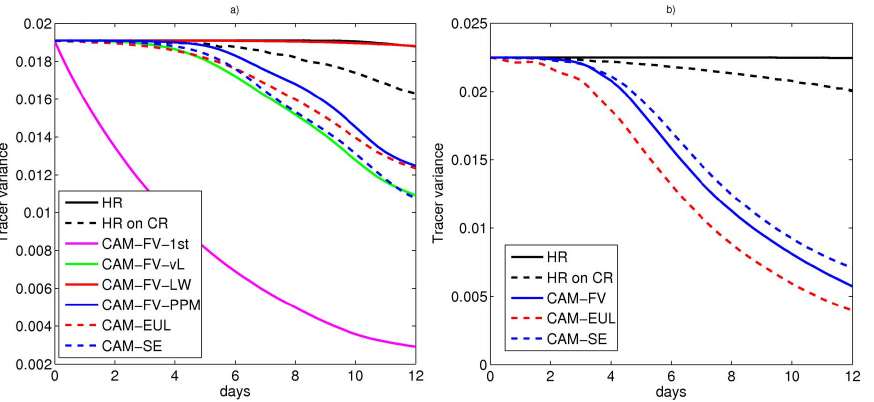
Fig. 10. Normalized tracer variance against time for (a) the (HR) CAM-FV reference solution, (CR) reference solution averaged onto the coarse grid, CAM-FV at 2 ◦ × 2 ◦ resolution with the (1st) 1st-order, (vL) van Leer, (LW) Lax–Wendroff, and PPM with the default limiter schemes, CAM-EUL at T85 resolution and CAM-SE, for test 1, and for (b) the (HR) CAM-FV reference solution, (CR) reference solution averaged onto the coarse grid, and the default versions of CAM-FV, CAM-EUL and CAM-SE for test 2.